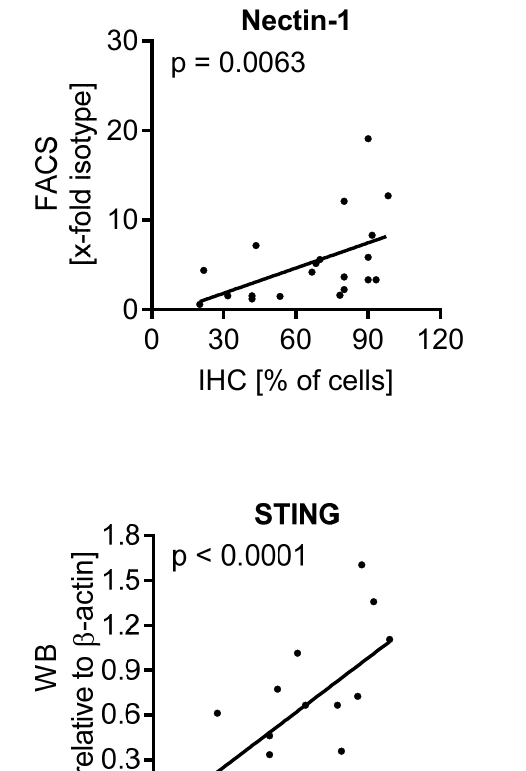
Figure 3. Correlation of the oncolytic activity of T-VEC with the expression of stimulator of interferon genes (STING) and cyclic GMP-AMP synthase (cGAS) in a panel of melanoma cell lines. ( A ) Western Blot analysis of STING and cGAS with respect to housekeeping protein ß-actin using lysates of 20 melanoma cell lines. ( B ) Densitometric quantification of STING and cGAS, normalized for ß-actin and shown as the mean and standard error of three independent Western blot experi- ments. ( C ) Spearman correlation coefficient, ( D ) box plot, and ( E ) ROC curve analyses of all responder and non-responder cell lines with respect to STING (upper part) and cGAS expression (lower part) and corresponding susceptibility to T-VEC induced cell death. p values for box plots were calculated using the Mann–Whitney test; ROC curves analyzed the area under the curve (AUC).